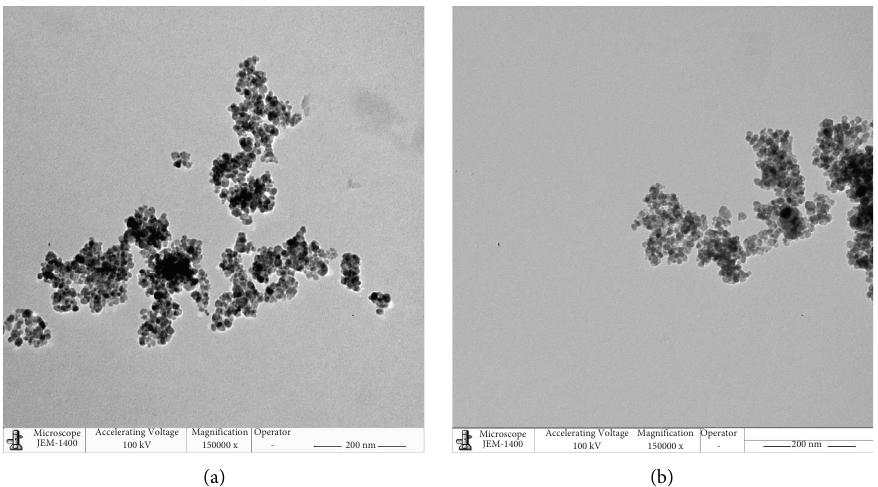
Figure 5: TEM micrograph of (a) AU-MNP and (b) AP-MNPs.